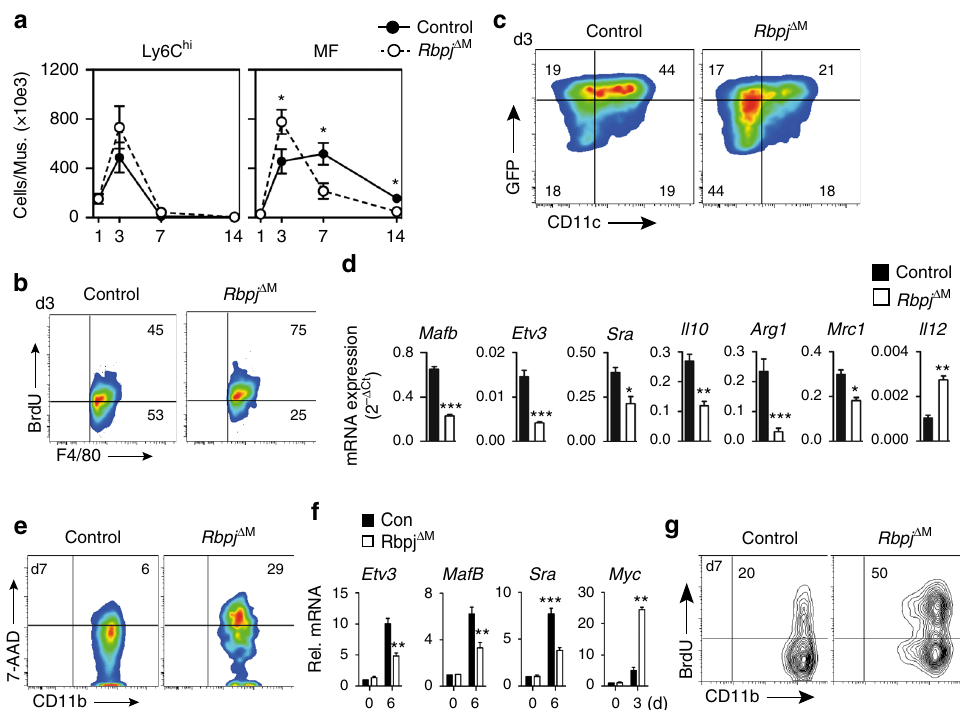
Fig. 6 Canonical Notch signaling regulates macrophage maturation in vivo. a Analysis of cell populations by fl ow cytometry in ischemic muscle of Rbpj conditional mutant mice ( Rbpj Δ M ) and control mice. n = 7/9 mice/group, error bars represent s.e.m., * p < 0.05 by two way ANOVA with Bonferroni post test. b Representative fl ow cytometry of 6 h in vivo BrdU incorporation in macrophages from ischemic muscle at d3. n = 3 independent experiments c Representative fl ow cytometry of macrophages (CD11b + , F4/80 + ) from ischemic muscle at d3. n = 4 independent experiments d Gene expression analysis of macrophages sorted from d3 ischemic muscle. n = 3 independent experiments, error bars represent s.e.m. *** p < 0.001, ** p < 0.01, * p < 0.05,